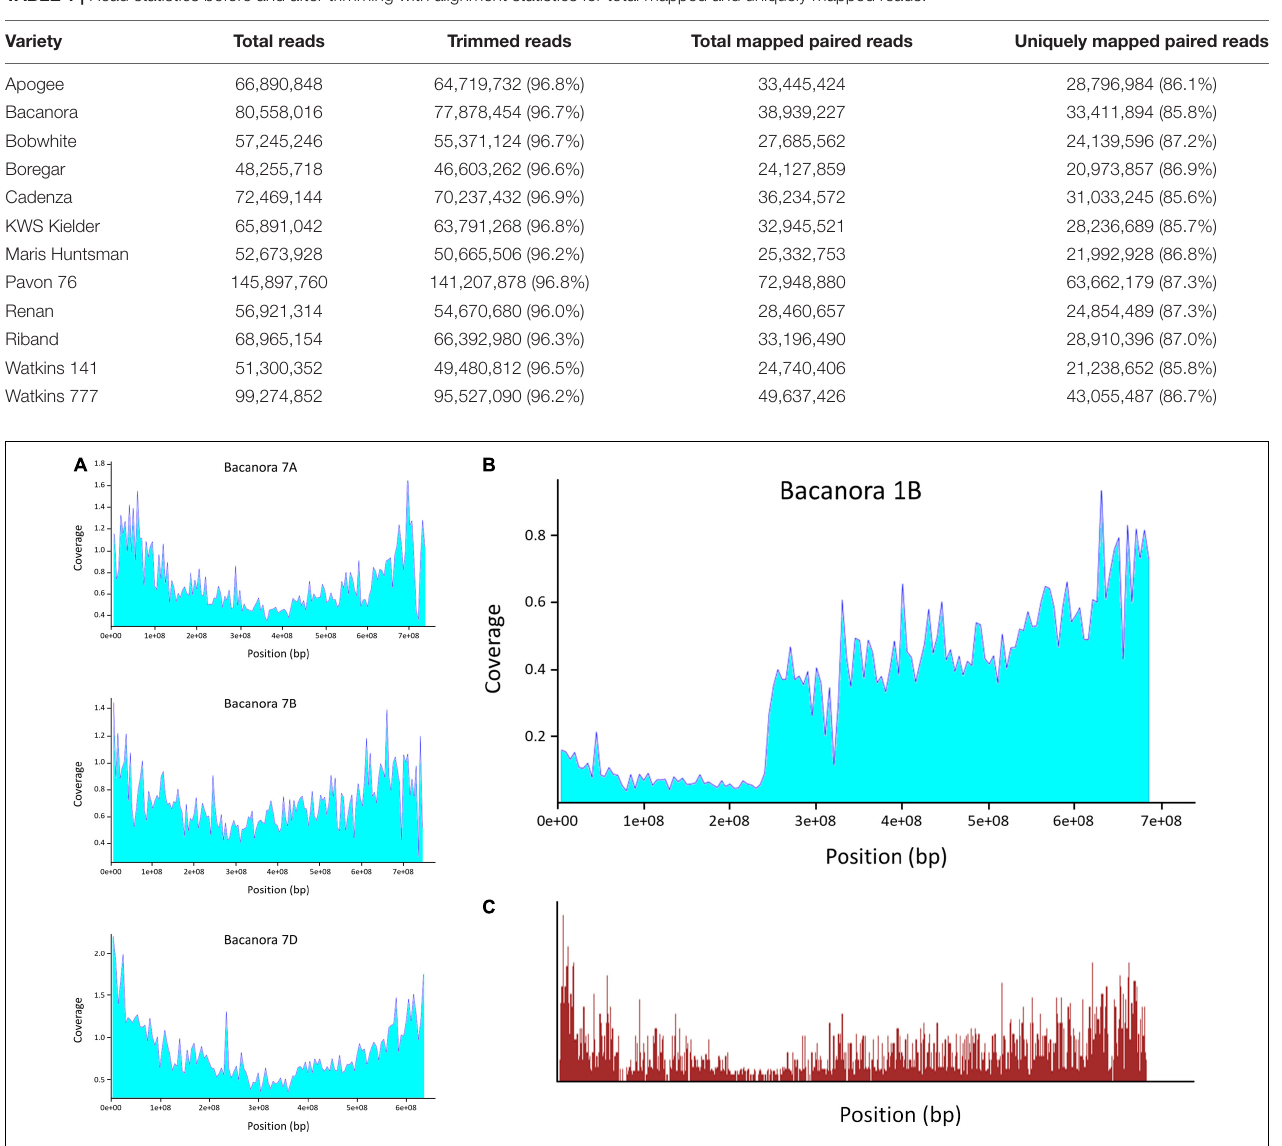
FIGURE 1 | Read coverage for the accession ‘Bacanora’ after alignment to IWGSC ‘Chinese Spring’ assembly version 1.0. (A) Read coverage across chromosomes tended to be higher toward the telomeres and lower across the centromere. (B) Chromosome 1B shows a clear drop in coverage across the short arm (NB in all plots, chromosome short arms are on the left). (C) Location and density of capture probes across chromosome 1B (data from Gardiner et al.,